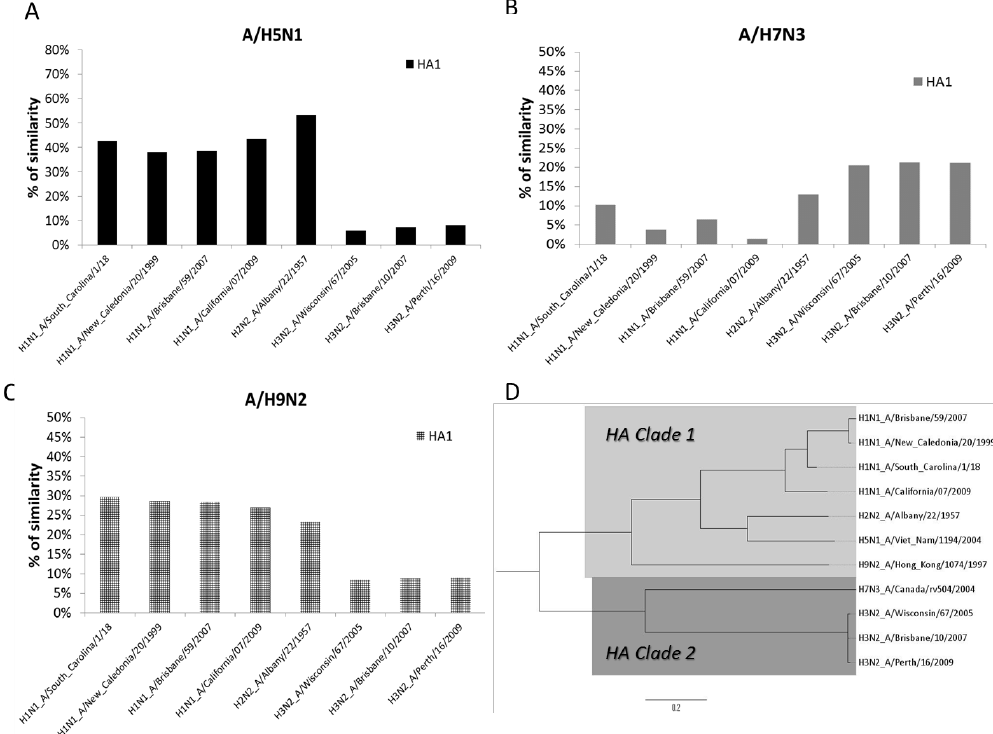
Figure 1. Percentage of the similarity between HA1 subunits of avian influenza viruses analyzed and those included in seasonal vaccines, as well as other influenza viruses of epidemiological interest. ( A ) Percentages of similarity against A/H5N1 avian influenza virus; ( B ) percentages of similarity against A/H7N3 avian influenza virus; ( C ) percentages of similarity against A/H9N2 avian influenza virus; and ( D ) the phylogenetic tree of the whole HA gene DNA sequence of avian influenza viruses, seasonal A influenza viruses, and other viruses of epidemiological interest.